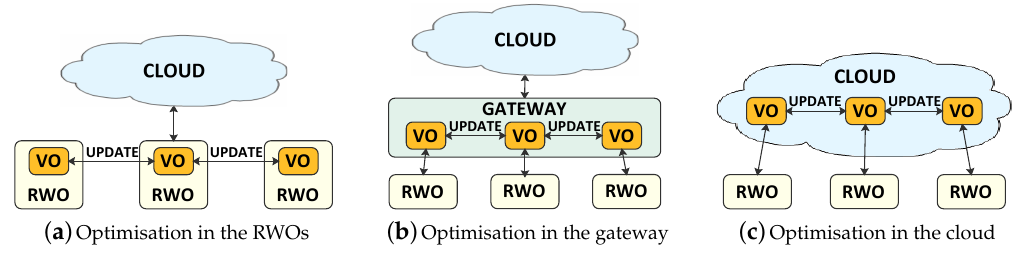
Figure 4. Location of the proposed algorithm into three typical IoT scenarios with reference to objects’ resource